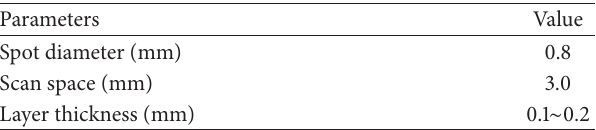
Table 1: The SLS process